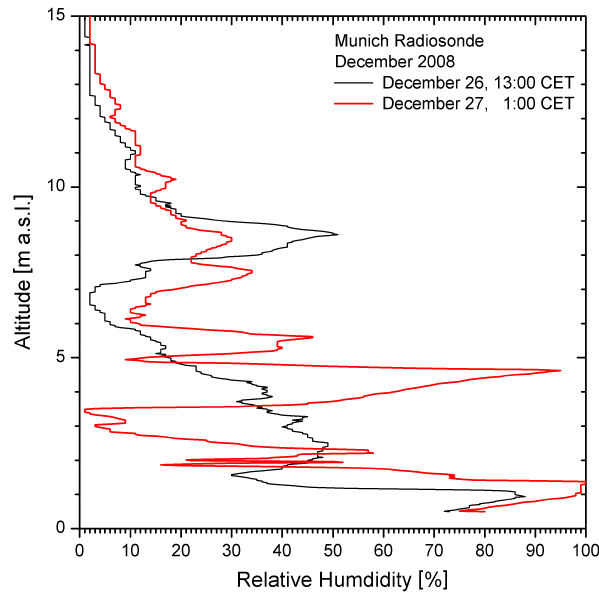
Figure 8. RH profiles of the Munich radiosonde on 26 and 27 De- Fig. 8. Relative-humidity profiles of the Munich radiosonde on December 26 and 27, 2008 (source: cember 2008 (source: German Weather Service); the intrusion layer German Weather Service); the intrusion layer is seen at 6.7 km (December 26, 13:00 CET) and at is seen at 6.7km (26 December, 13:00CET) and at 3.4km (27 De- 3.4 km (December 27, 1:00 CET). Please, note that the sonde data are cut off at 1 % RH. Thermal cember, 1:00CET). Note that the sonde data are cut off at 1% RH. Thermal tropopause: 11.3 and 10.2km, tropopause: 11.3 km and 10.2 km, respectively.